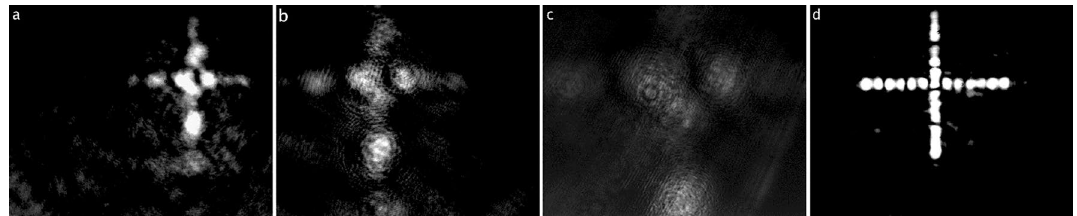
Figure 2. The use of a DOE inside the SCL allows to project a cross on the CMOS sensor at a distance (( a ) 7.5 cm, ( b ) 12 cm, ( c ) 20 cm). ( d ) Test outside of the SCL. Better image quality can be obtained on the CMOS sensor at 7,5 cm if the VCSEL beam illuminates a larger area of the